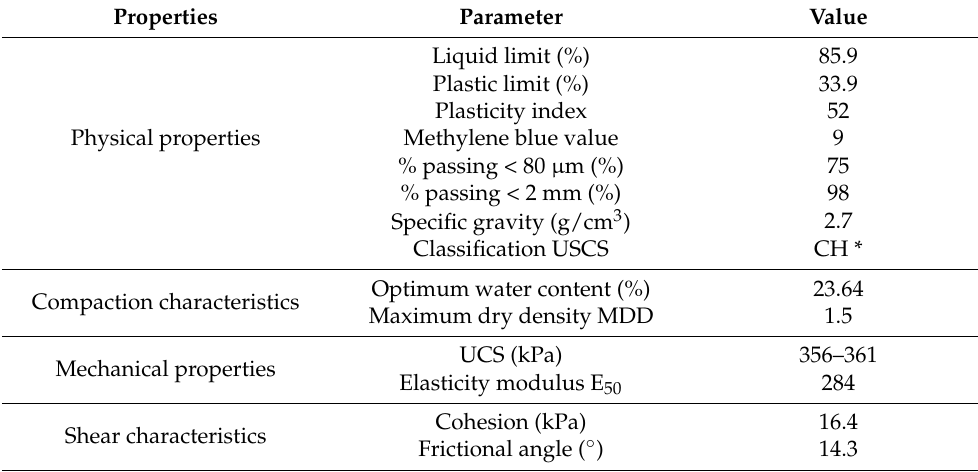
Table 1. Properties of clay used.